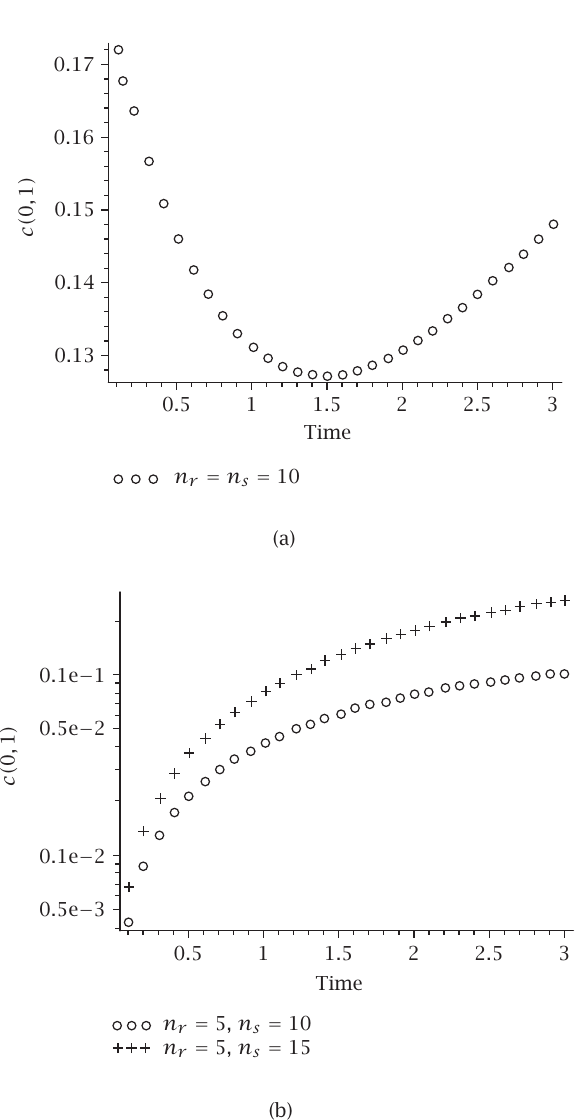
Figure 4.1 . The monomer concentration of the two-component Becker- Döring system c( 0 , 1 ) against time. The densities are ρ I ( 0 ) = ρ II ( 0 ) = 1 . 5 and kinetic coefficients are as in